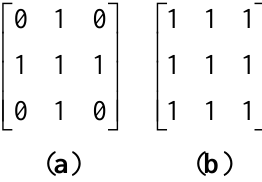
Figure 5. Two types of connectivity: ( a ) 4-connectivity; ( b )